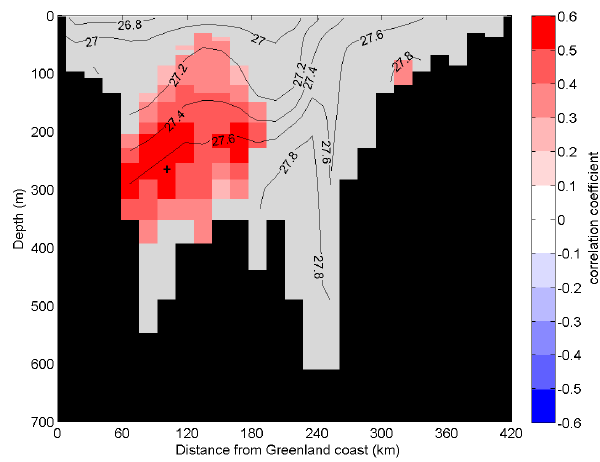
Fig. 6. Section through the overflow sill in OCCAM, showing the correlation coefficient between mooring UK1 salinity anomaly time series and the equivalent OCCAM salinity anomaly time series in each grid cell ( p < 0 . 01). Contours indicate the 11-year mean of OCCAM potential density. Grey indicates no statistically significant correlation.